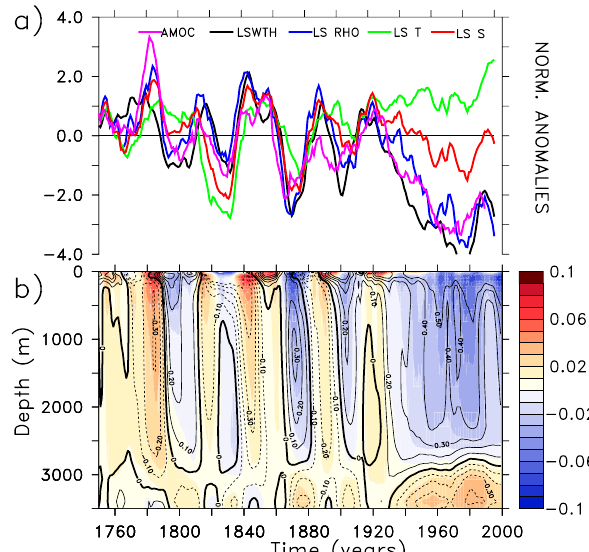
Figure 8. (a) Evolution of the Labrador Sea Water thickness (LSWTH, defined as the depth difference between the isopycnals σ 2 = 36 . 74 and σ 2 = 36 . 82, averaged over 60–45 ◦ W, 50–60 ◦ N), AMOC stream function at 30 ◦ N and 1500m depth (displayed here with a 10-year time-lag), and surface water mass properties in the region where convection takes place in the Labrador Sea: density (LS RHO), temperature (LS T), and salinity (LS S). All time series are smoothed using an 11-year running mean and are shown as nor- malized anomalies w.r.t. the pre-industrial means. (b) Evolution of potential density (colour shading) and potential temperature (con- tours, contour intervals 0.05K) as function of depth and time for the Labrador Sea in the pr2 simulation. An 11-year running mean was applied to the